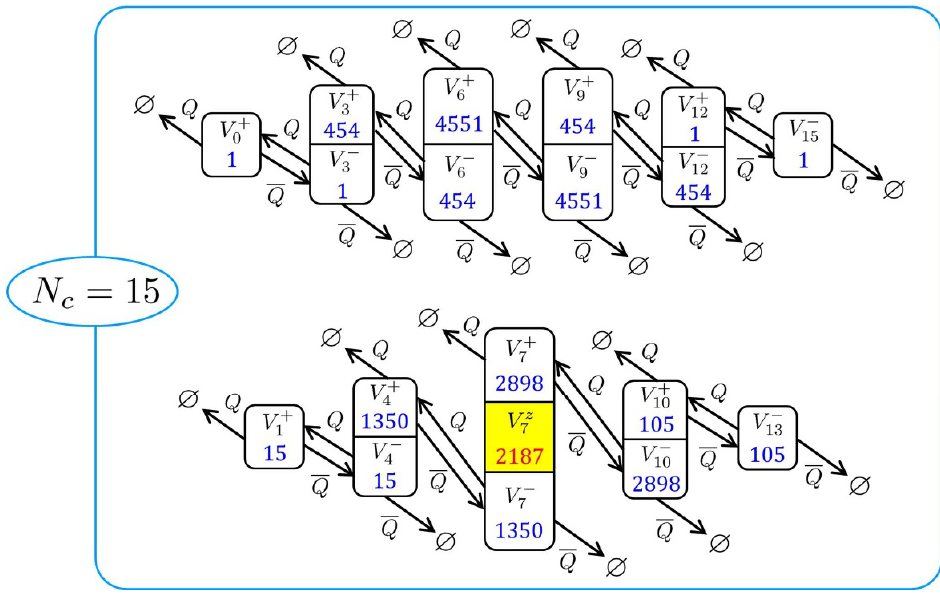
Figure 11 . Relations among the Hilbert spaces with F = 0 and 1 (mod 3) for N c = 15. The numbers shown are the dimensions of the corresponding subspaces of V . Arrows to the symbol ? (empty set) are shown to emphasize the nilpotency Q 2 = Q 2 = 0.